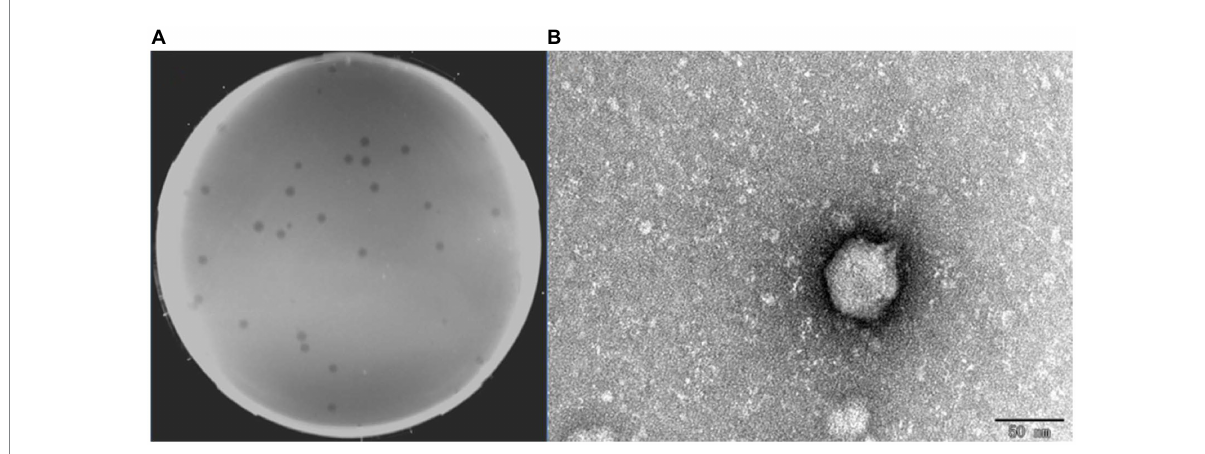
FIGURE 1 Plaques and transmission electron micrograph of phage BUCT609. (A) Plaques formed by BUCT609. (B) Transmission electron micrograph of phage BUCT609. Scale bar 50